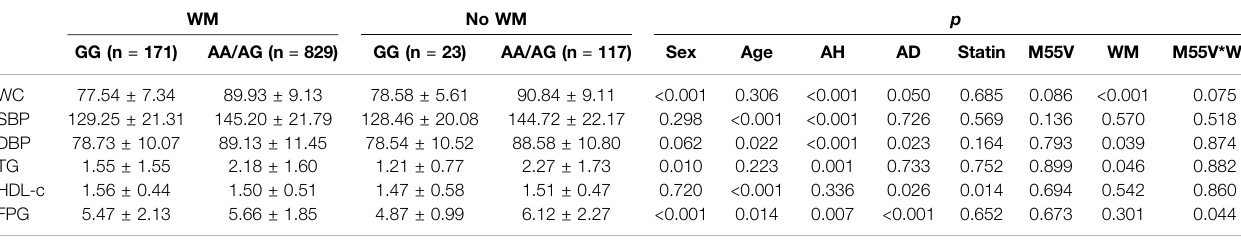
TABLE 5 | Covariance analysis of MetS components in the 5-years follow-up survey.